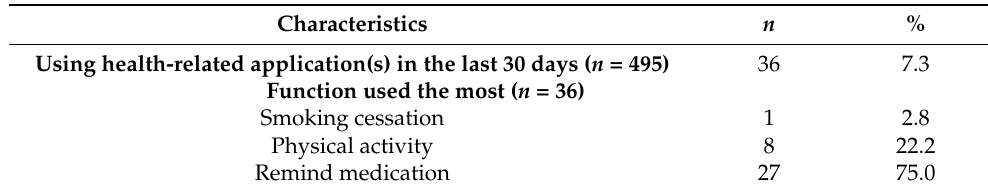
Table 2. Health-related smartphone application use, demand and willingness to pay